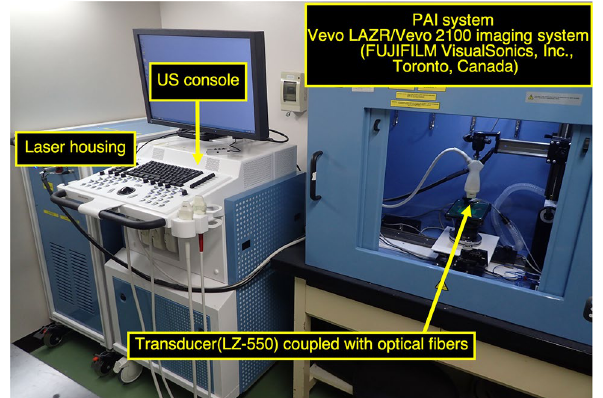
Figure 5. Commercially available photoacoustic imaging systems. Vevo LAZR uses handheld transducers for laser delivery and photoacoustic signal detection.